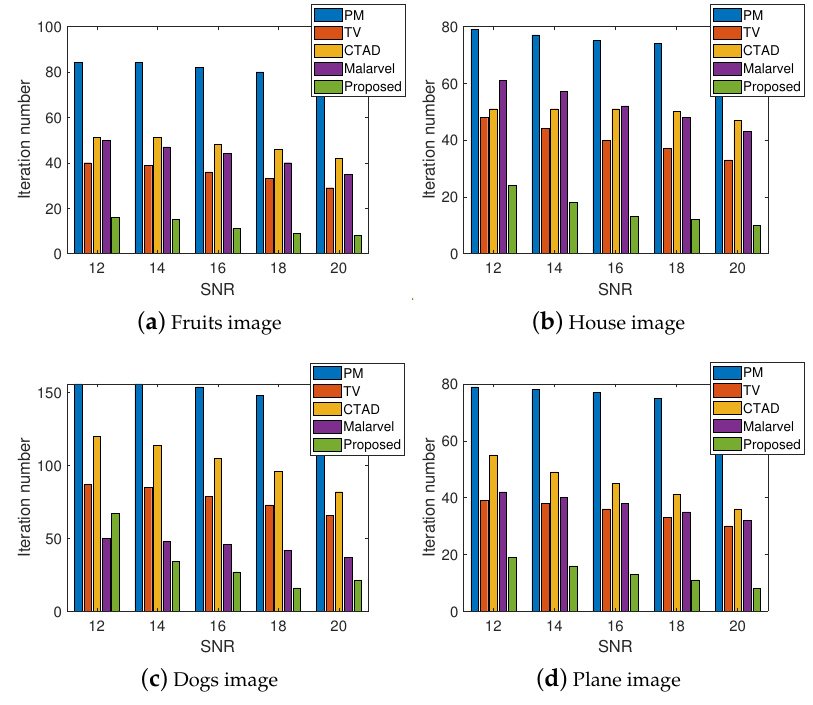
Figure 10. Iteration